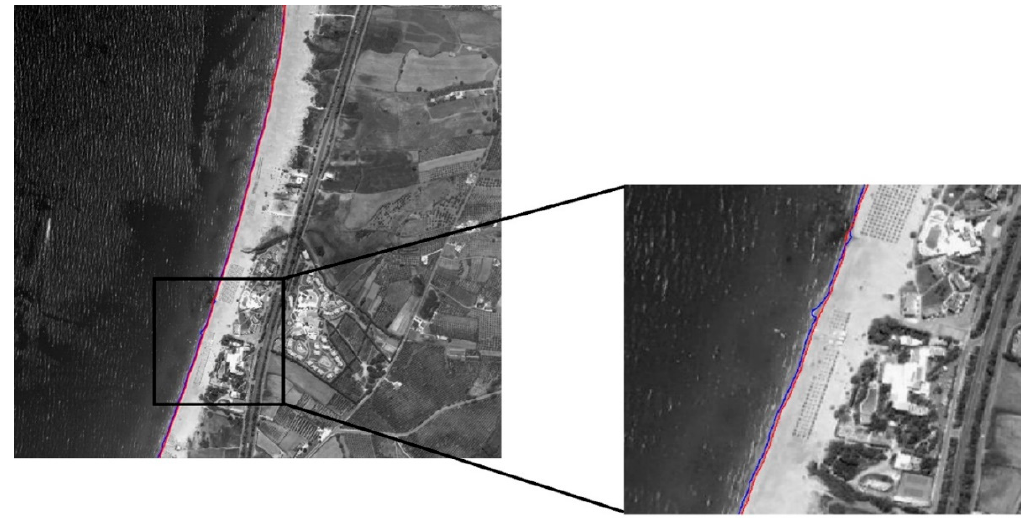
Figure 11. Estimation of the coastline and a close-up of the coastline area, applied on the second data set of aerial images. The blue line indicates the first estimation and the red line indicates the final line.